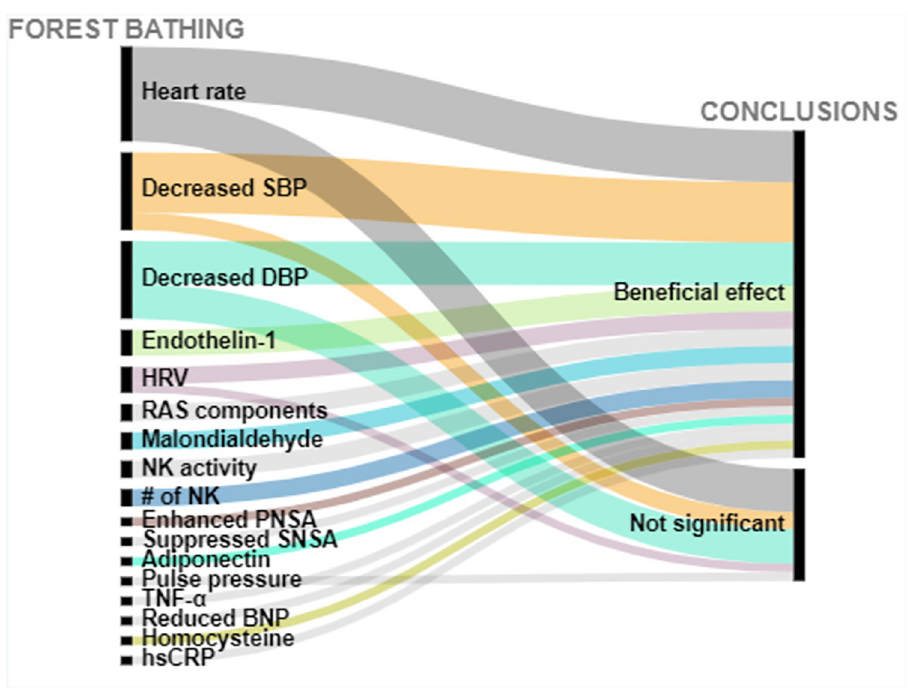
Fig 4. Forest bathing intervention effects on both CV health and cancer-related outcomes: Trends of associations among all statistical tests conducted. The first column represents outcome measures while the second column represents summary conclusions in terms of protective effects (beneficial effect) or no significant results (not significant). Acronyms : SBP 1 : Systolic blood pressure; DBP 2 : Diastolic blood pressure; BNP 3 : Brain natriuretic peptide; HRV 4 : Heart rate variability; RAS 5 : Renin-angiotensin system components; PNSA 6 : Parasympathetic Nervous System Activity; SNSA 7 : Sympathetic Nervous System Activity; hsCRP 8 : High sensitivity C-reactive protein, TNF- α 9 : Tumor necrosis factor alpha; and NK 10 : Natural killer